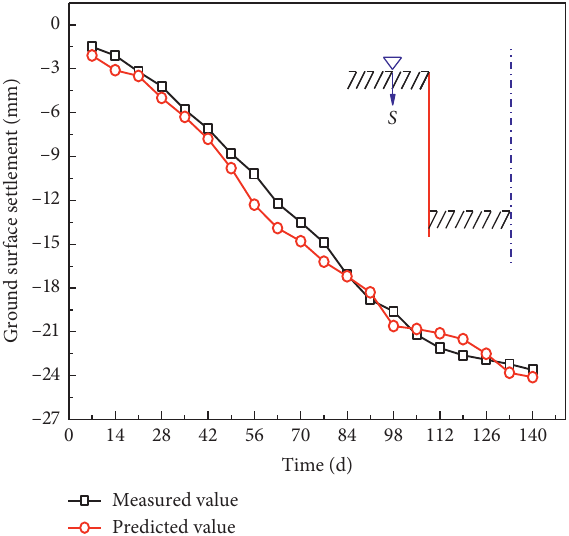
Figure 8: Maximum surface settlement change curve.